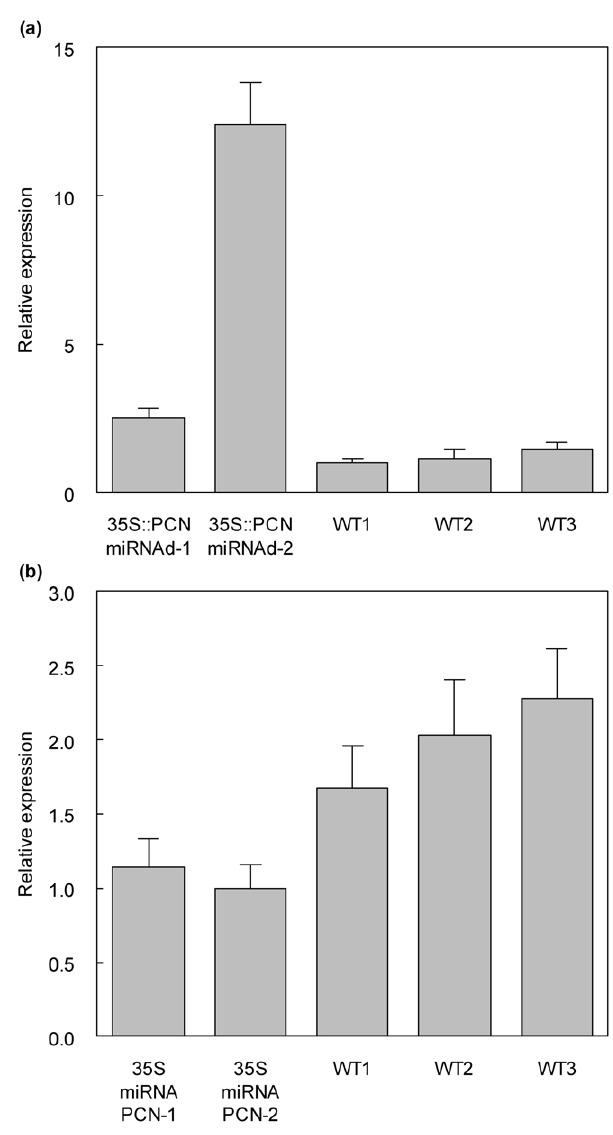
Figure 4. PCN expression levels in PCN35S::PCN-miRNAd gain of function and 35S::miRNA-PCN knockdown transgenic plants relative to wild-type controls. PCN expression levels were detected by Quantitative Real Time PCR (Materials and Methods). Relative expression levels (mean 6 SE) were calculated from triplicate qRT-PCR reactions of independent RNA samples for each transgenic and the wild-type prepared from different batches of two month-old plants. T test (P , 0.05) comparison showed significant differences of expression in all transgenics compared to the wild-types. (a) Comparison PCN transcripts in wild-type and 35S::PCN-miRNAd gain of function plants. (b) Comparison PCN transcripts in wild-type and 35S::miRNA-PCN plants. doi:10.1371/journal.pone.0017458.g004 (Fig. 4a). Only modest downregulation of PCN transcript abundance was found for artificial miRNA lines (up to approximately two-fold reduction in line 35S::miRNA-PCN-3-4), indicating the artificial miRNA was only partially effective in reducing PCN transcripts (Fig. 4b). Compared with matched wild-type controls (Fig. 5a), 35S::PCN-miRNAd-4-3 plants have shorter internodes, darker green leaves, and large stipules (Fig. 5b). The mutants did not present any obvious polarity defects, barren axils, or root